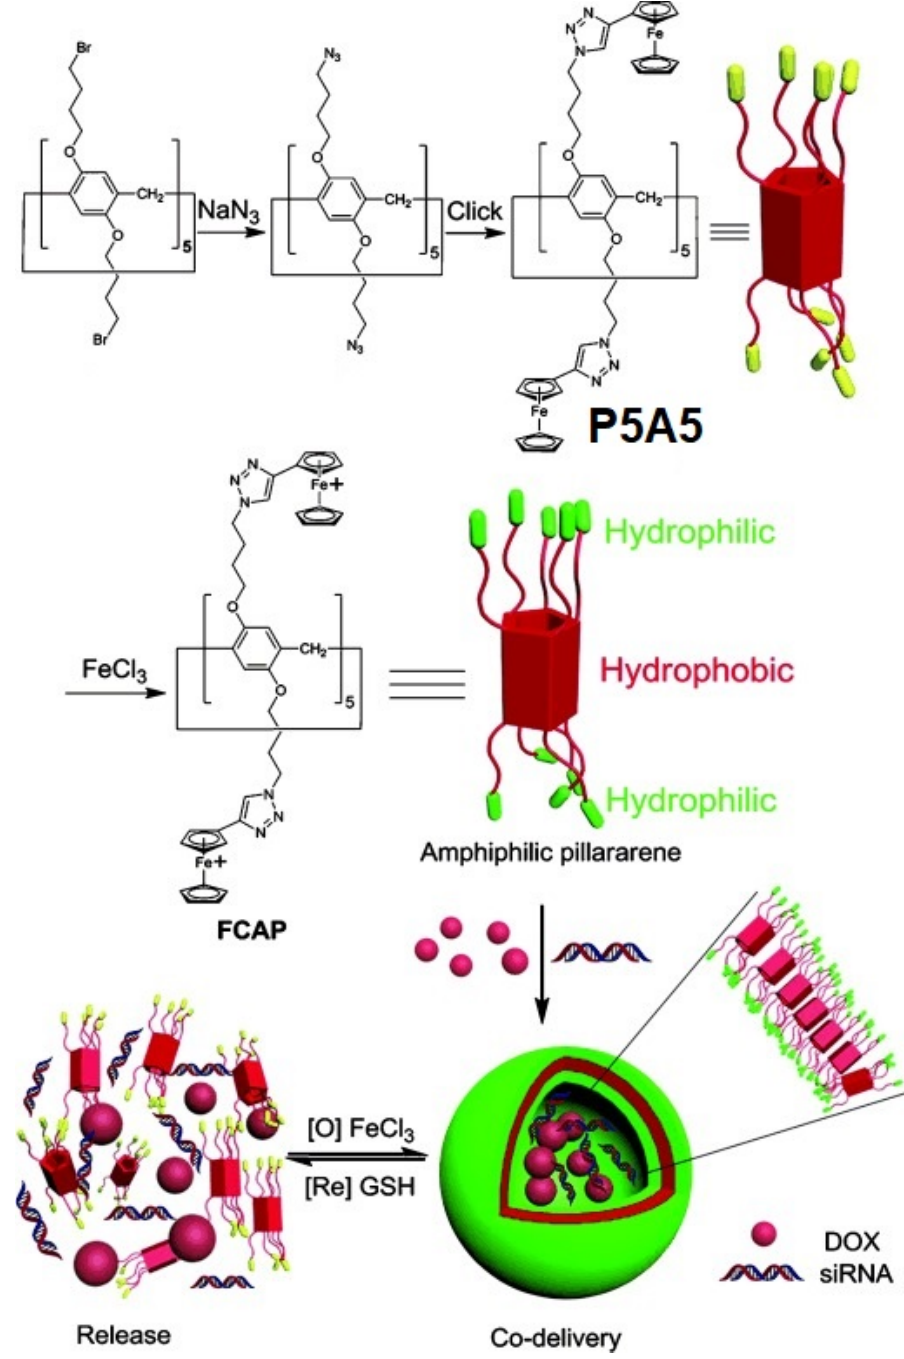
Figure 17. Illustration of the synthesis of FCAP , formation of cationic vesicles, and their redox-re- sponsive drug/siRNA release. Reproduced with the permission of reference [17]. Copyright © Wiley 2015.